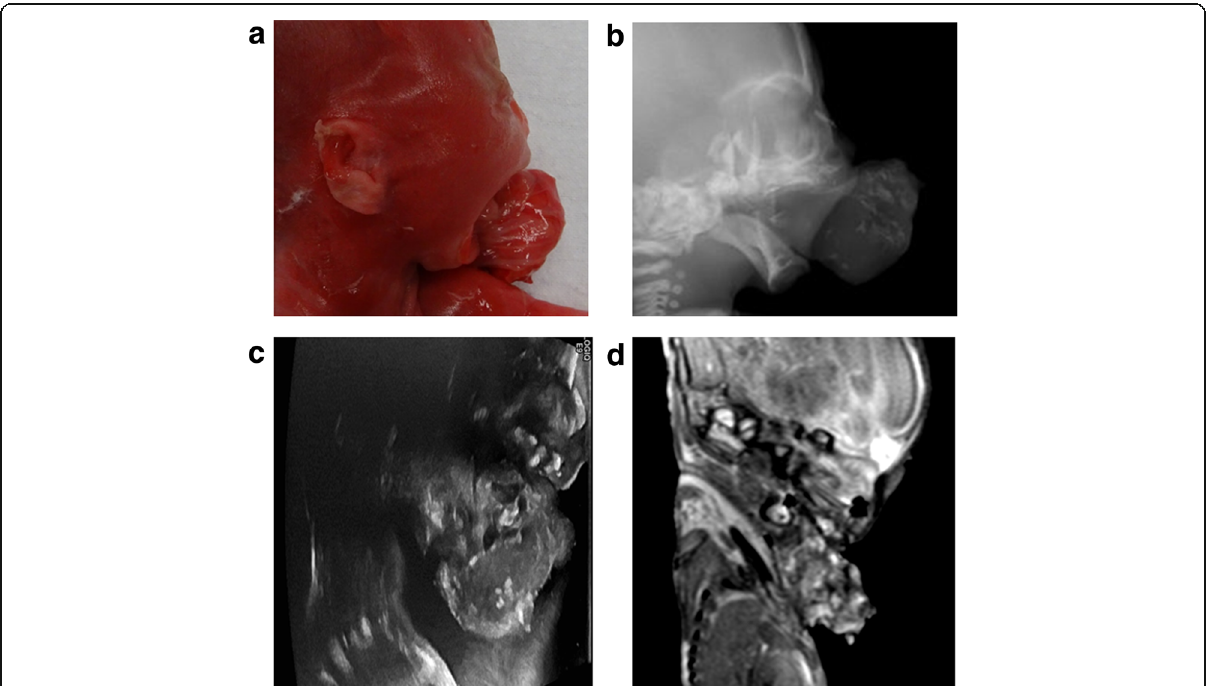
Fig. 6 Epignathus arising from the hard palate in a foetus at 21 weeks gestation, after a termination of pregnancy for suspected anterior encephalocele. The photograph taken prior to autopsy of the head ( a ) demonstrates a large soft tissue mass arising from the oral cavity. The corresponding lateral radiograph of the head ( b ) demonstrates multiple calcific components within. A sagittal view during post- mortem ultrasound ( c ) and post-mortem MRI ( d ) obtained 7 days after delivery, both demonstrate the heterogenous internal nature of the oral mass, although it is much harder to identify the origin of the mass on the PMMR given the position, resolution and slumping of the foetus in the